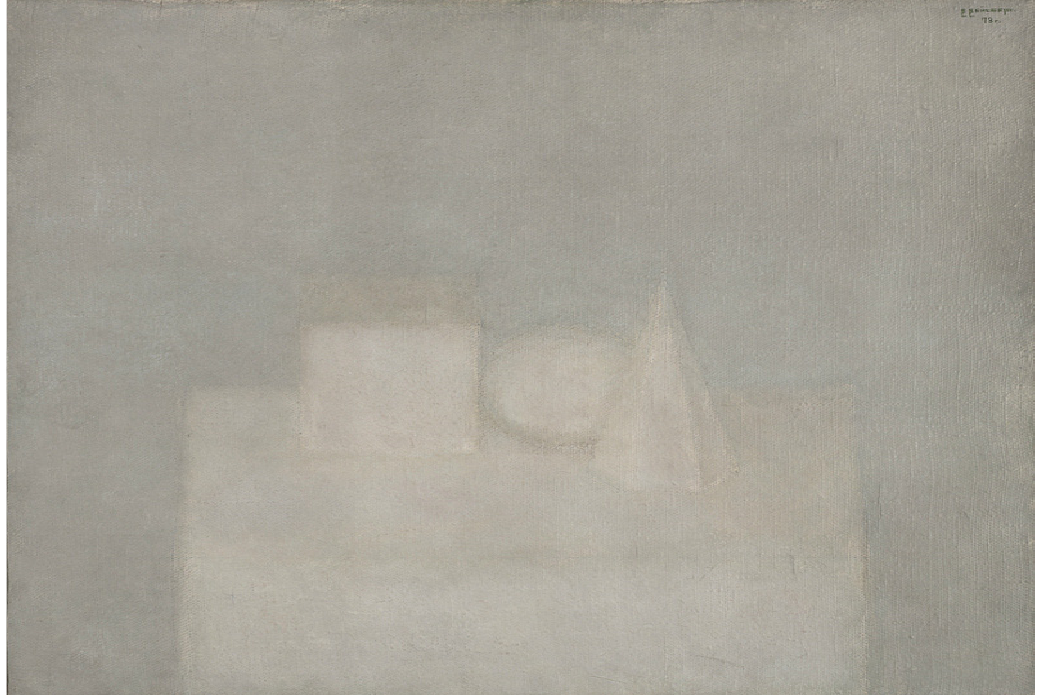
Figure 3. Vladimir Veisberg. The cube, sphere and pyramid, 1973. Oils on canvas, 55 * 58. Art4 Museum, Moscow (Igor Markin’s collection). https://www.art4.ru/museum/shteynberg-eduard/ (accessed on 22 May 2022).